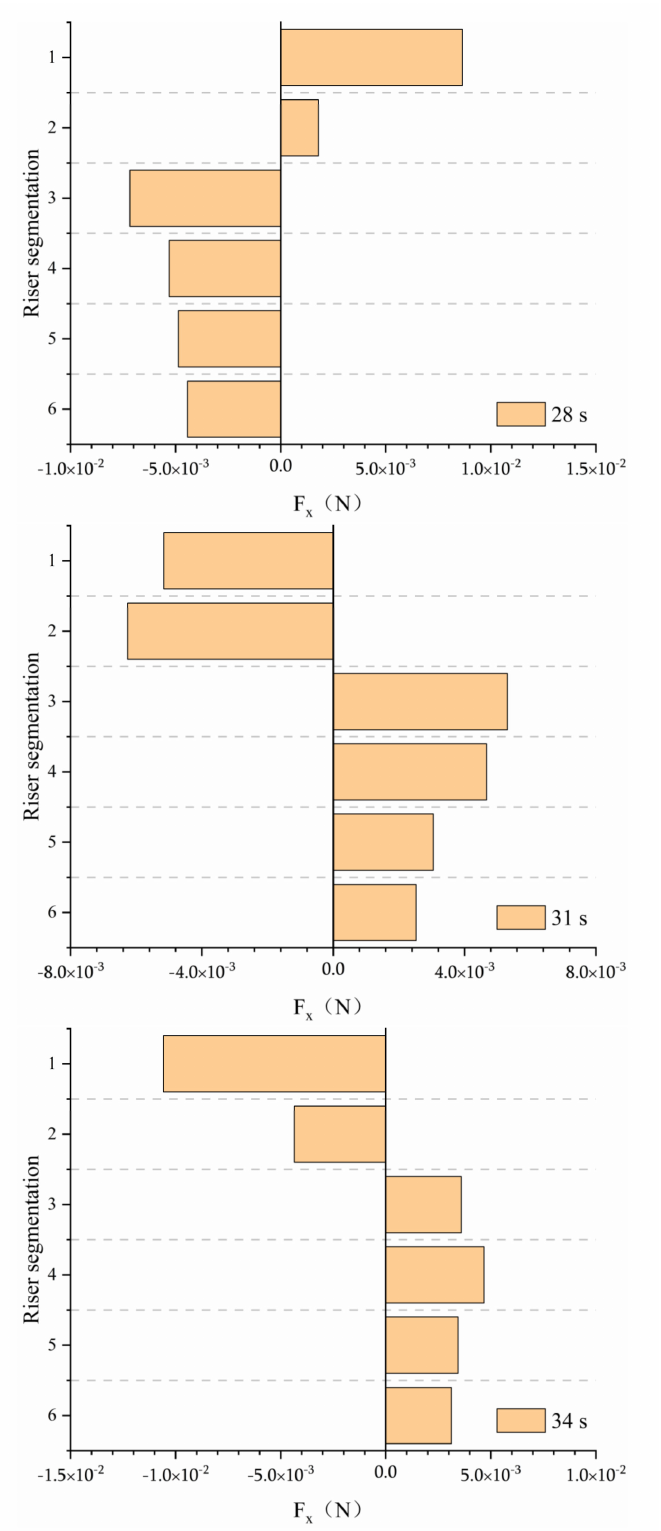
Figure 15. Vertical distribution of force on riser segments at different moments (working condition